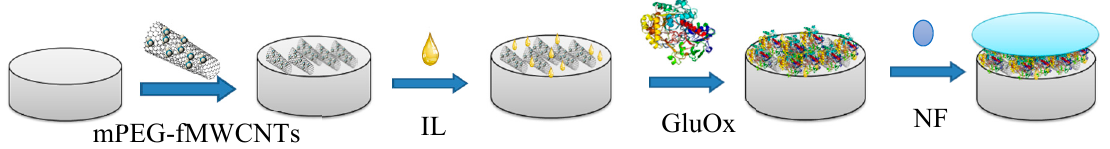
Scheme 1. Preparation process of functional polymer modified GCE.